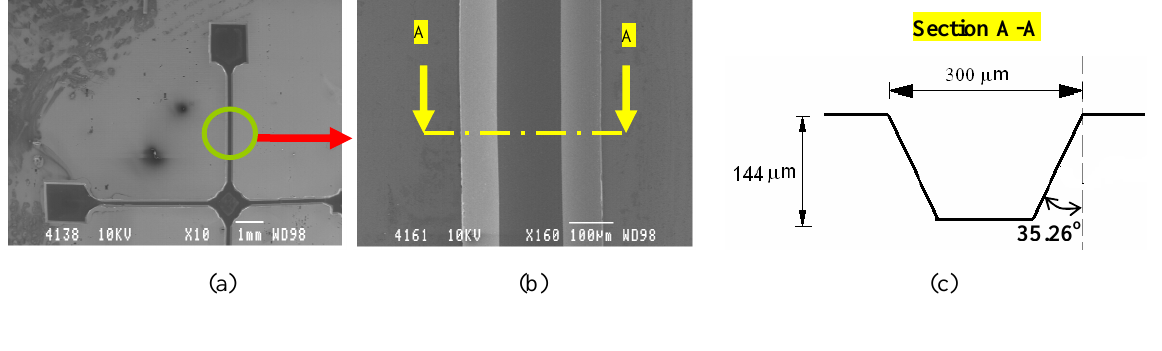
Figure 4: Anisotropically etched microfluidic channel with sidewall inclination angle of o 35.26 (a) Microfluidic chip (b) Smooth micro machined channel surface (c) Cross- section of the microfluidic